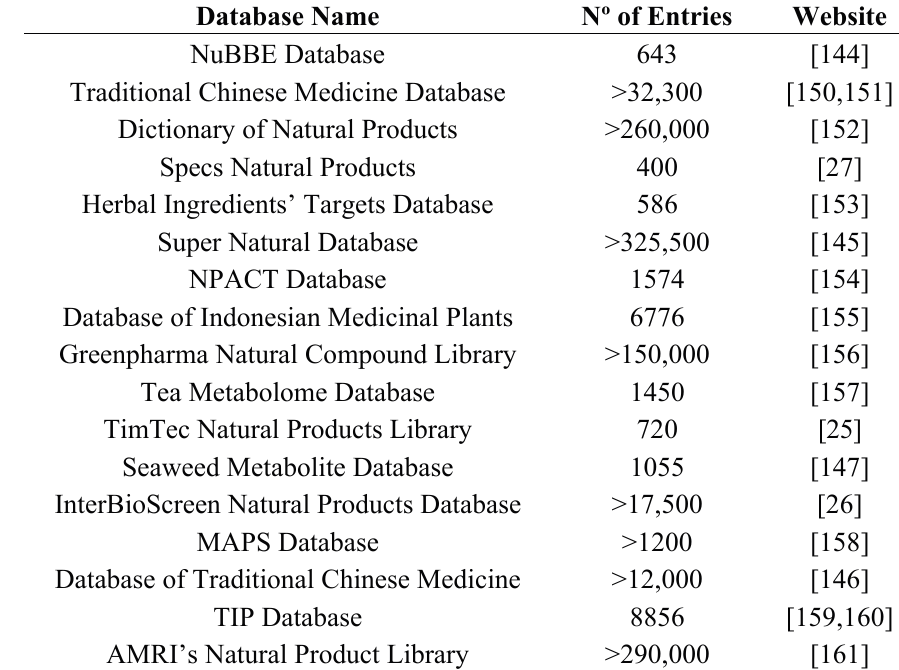
Table 1. Some available NPs databases for virtual